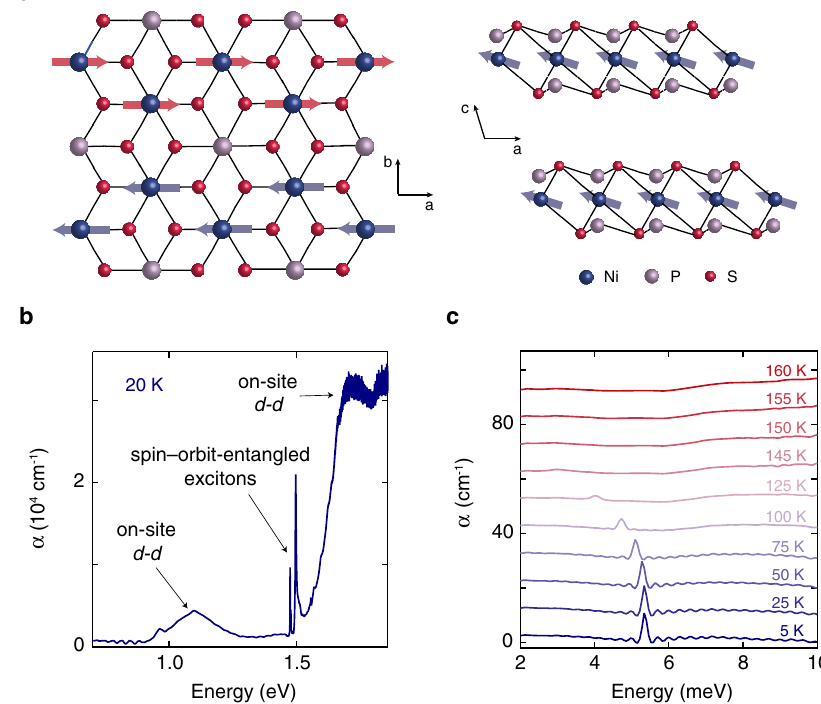
Fig. 1 Crystal structure and optical properties of NiPS 3 . a Crystal and magnetic structure of NiPS 3 . The Ni atoms (blue spheres) are arranged in a two- dimensional honeycomb lattice in the ab -plane. The magnetic moments (red and blue arrows), which point mostly along the a -direction, form a zigzag antiferromagnetic pattern with weak ferromagnetic coupling in the c -direction. b Optical absorption ( α ) of NiPS 3 below the charge-transfer gap at 20 K. The features around 1.5 eV are the spin – orbit-entangled exciton transitions reported in ref. 5 . The broad structures around 1.1 and 1.7 eV are on-site d - d transitions. The data is adapted from ref. 5 . c Absorption spectrum in the THz range at various temperatures. The traces are offset vertically by 10 cm − 1 for clarity. The low-temperature curves show an absorption peak corresponding to a magnon resonance. The magnon energy softens with increasing temperature and the mode disappears above T N = 157